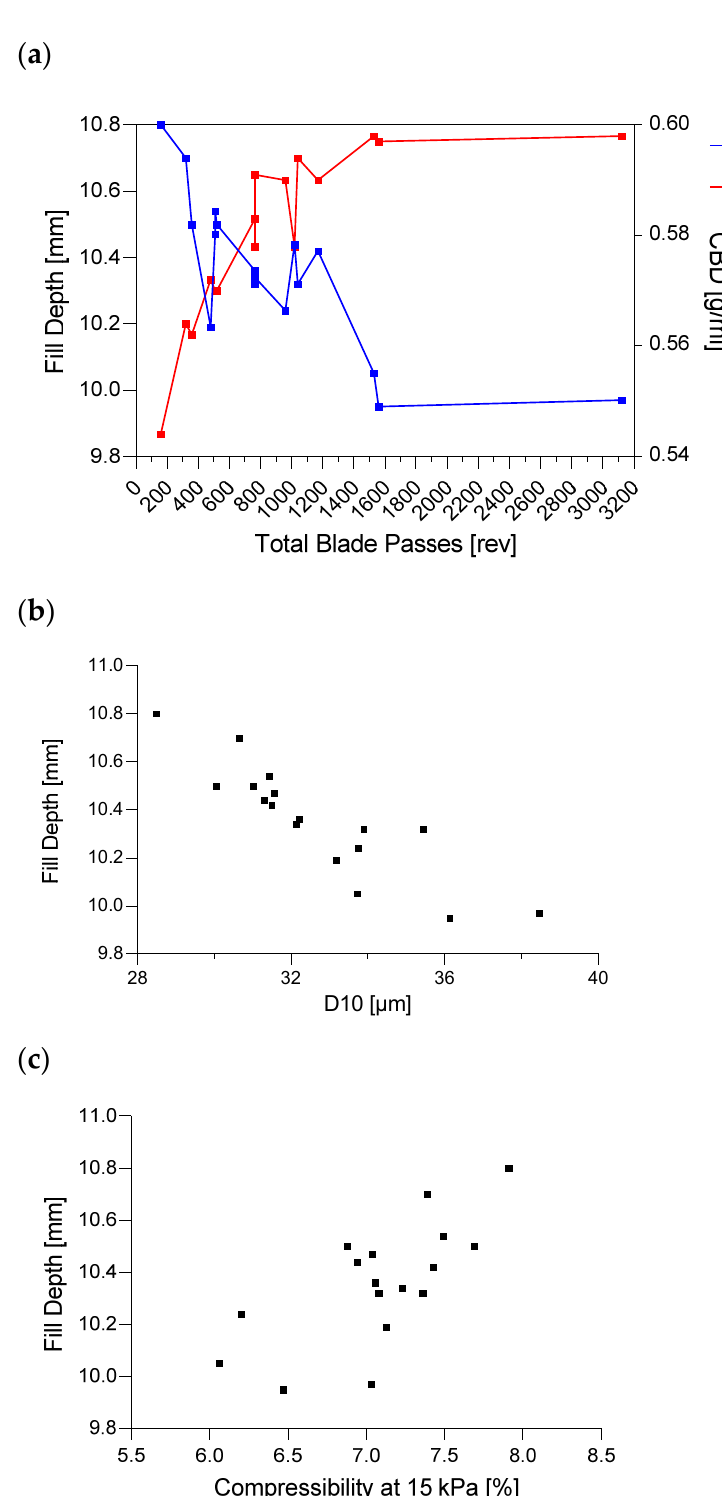
Figure 17. ( a ) Fill depth as function of total blade passes compared to bulk density. ( b ) Linearity between fill depth and d 10 values. ( c ) Impact of compressibility on fill depth.